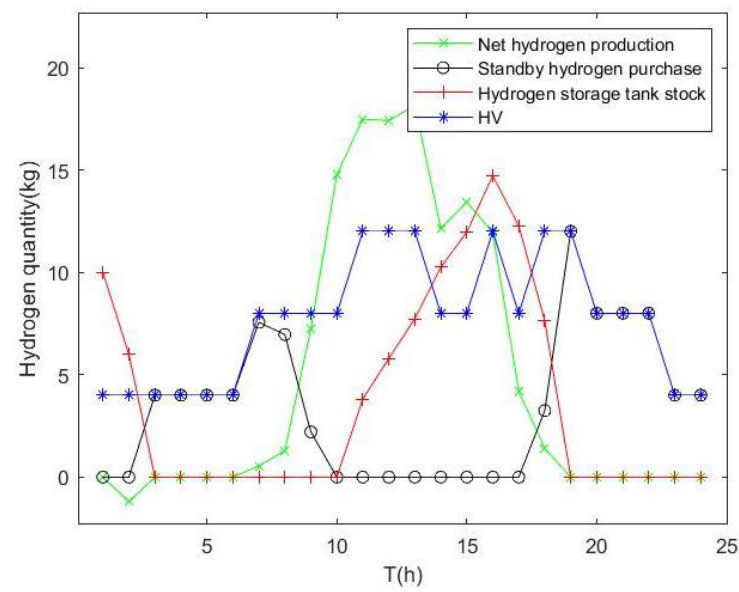
Figure 6. Hydrogen balance. Figure 6. Hydrogen